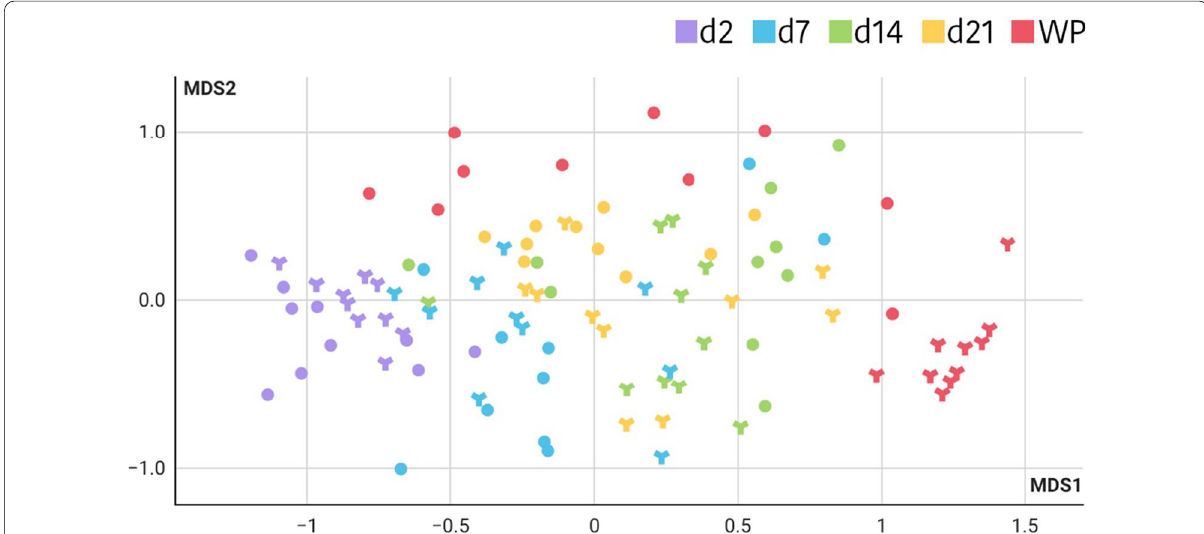
Fig. 1 NMDS of the relative abundances of ASV in Trial 1. Different colours have been used to highlight each sampling day. The farm of origin is indicated with a different shape, round for the Alpha farm and with a 3‑pointed star for the Bravo farm. A significant impact shaping the gut communities is produced by age and environmental factors ( p < 0.001) with five clusters that match with piglet age. A greater richness is observed in Bravo piglets when compared to Alpha’s ( p < 0.001), and with the increasing age of piglets ( p < 0.001), suggesting that as the piglets grow and the gut community becomes more diverse, the divergence among animals increases. The significant effect of the farm is observed more clearly when performing the analysis by sampling day (Additional file 1. Figure